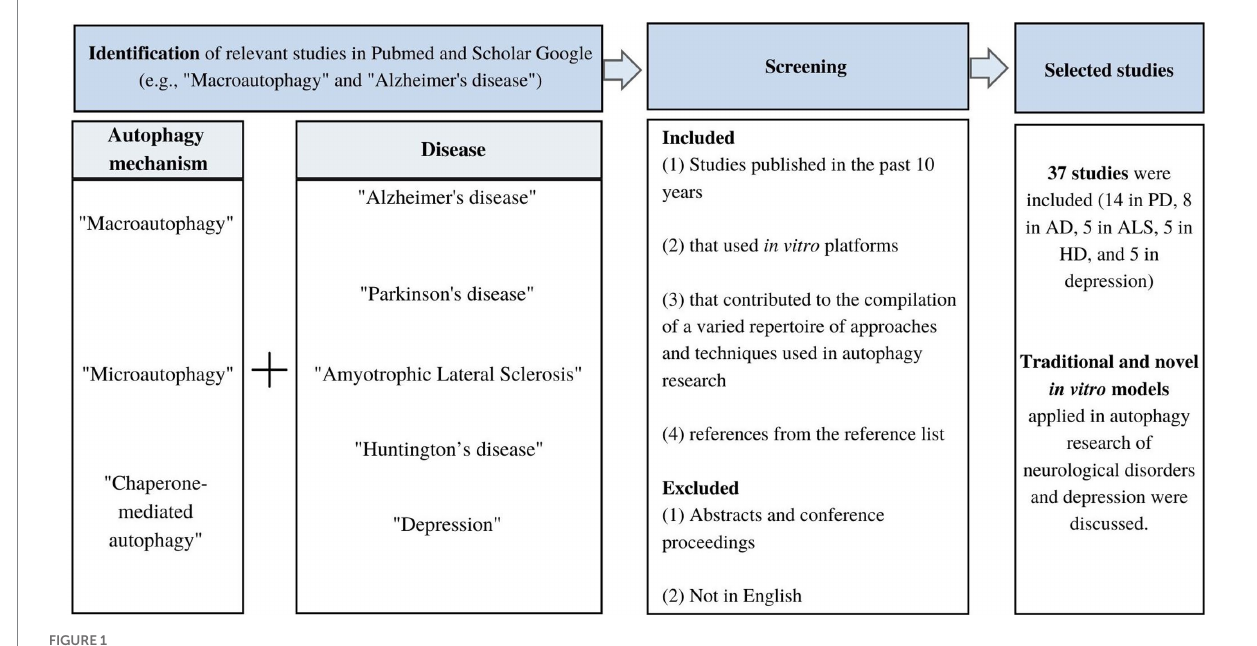
FIGURE 1 Flowchart of study screening and